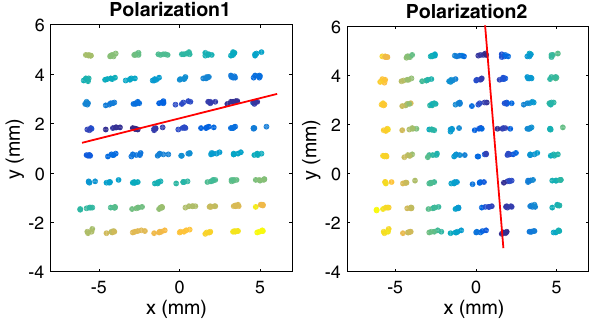
FIG. 12. Normalized amplitudes of the two polarizations as a function of beam positions. The dots are color coded by the normalized amplitudes giving a bright yellow point at one and a dark blue point at zero. The red lines indicate the polarization axes. Polarization one determines the horizontal axis and polari- zation two the vertical one.